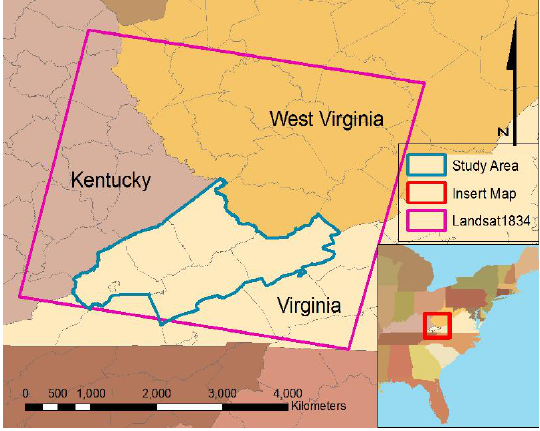
Figure 1. Map of study